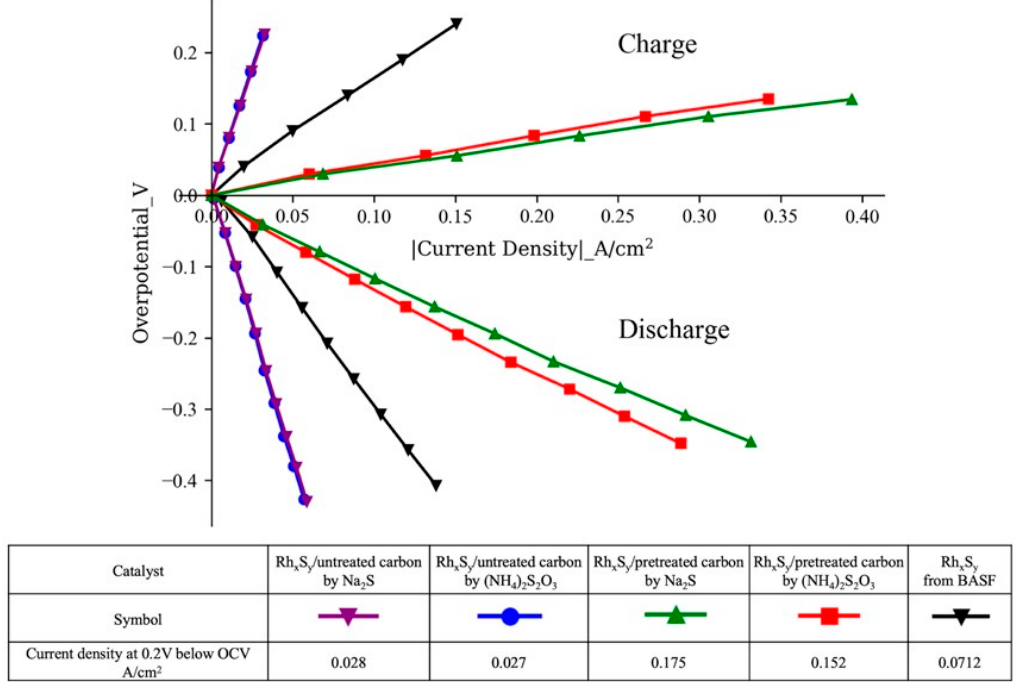
Figure 8. Discharge and charge polarization curves of H 2 -Br 2 fuel cells with different catalysts after full IR correction (weight ratio of Nafion ® ionomer:catalyst = 1:1).